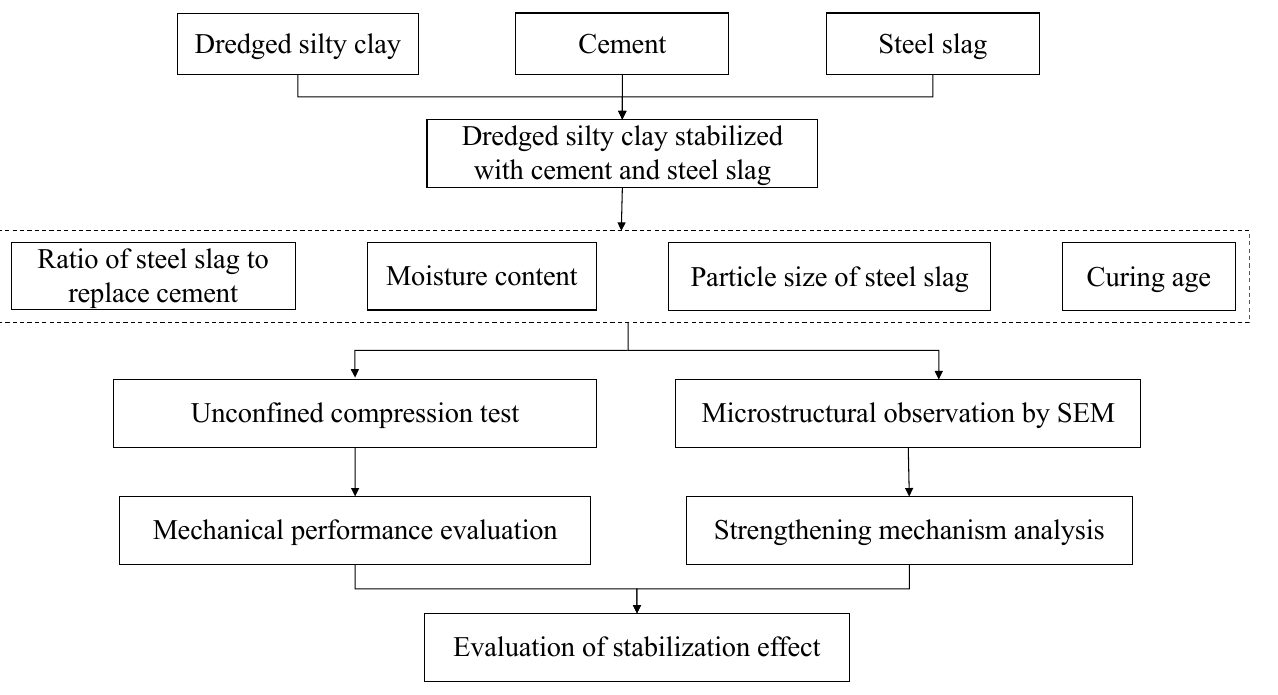
Figure 1. Systematic experimental technique route for this study.